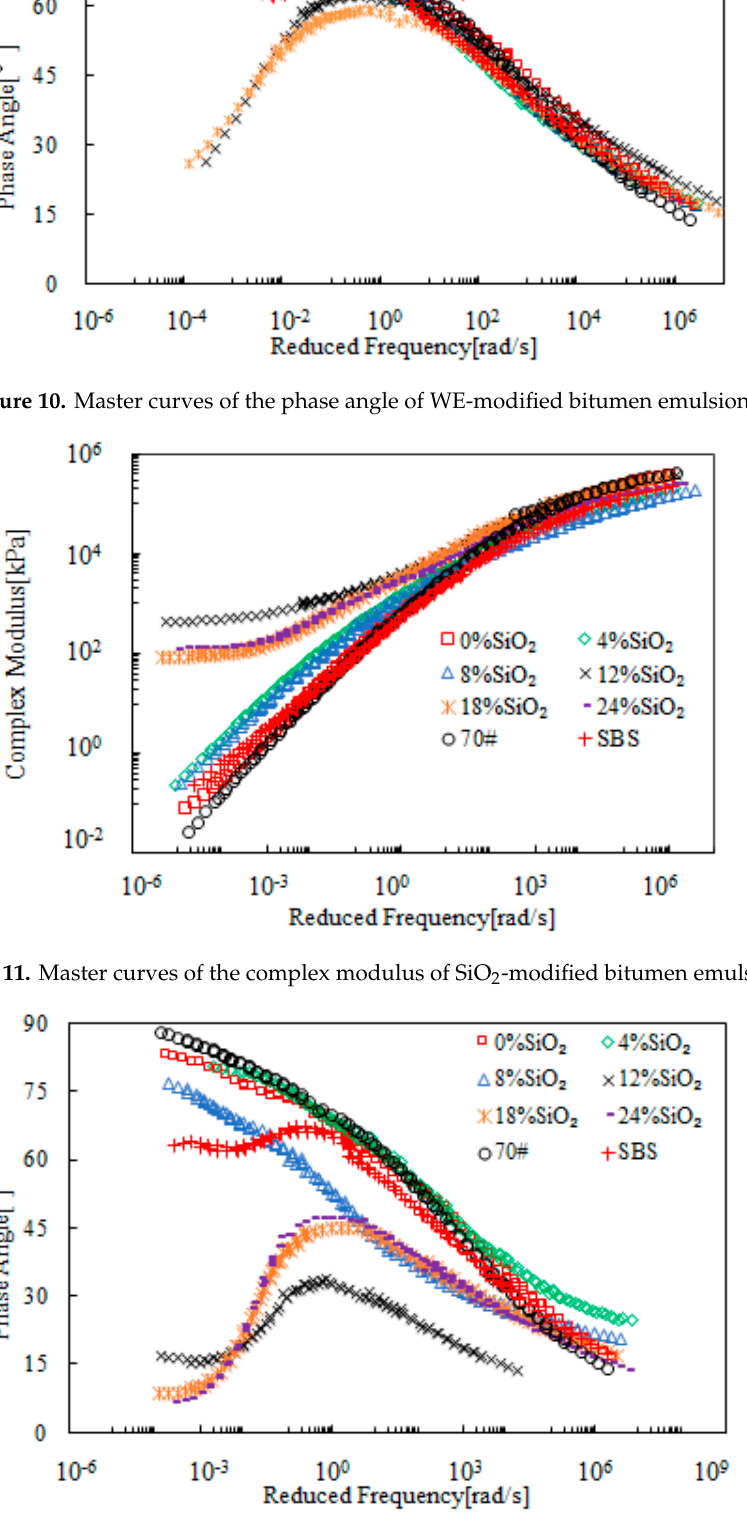
Figure 10. Master curves of the phase angle of WE-modified bitumen emulsion.